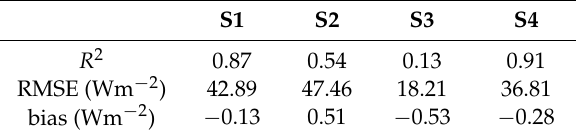
Table 7. Validation statistics for the MARS model for these four